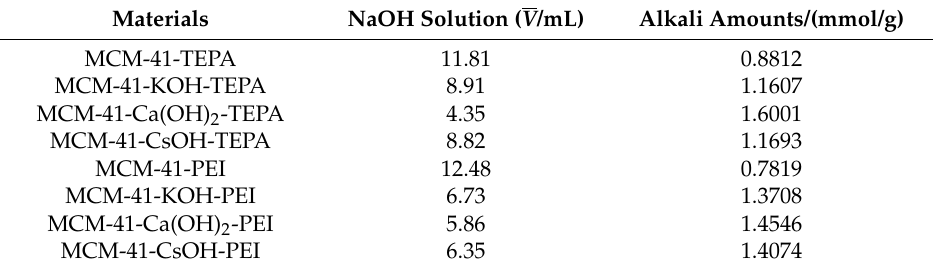
Table 2. Alkali amounts of various adsorbents.